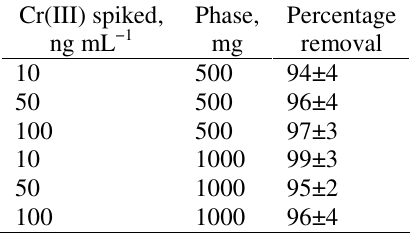
Table 2. Distribution coefficient ( K values of various metal ions